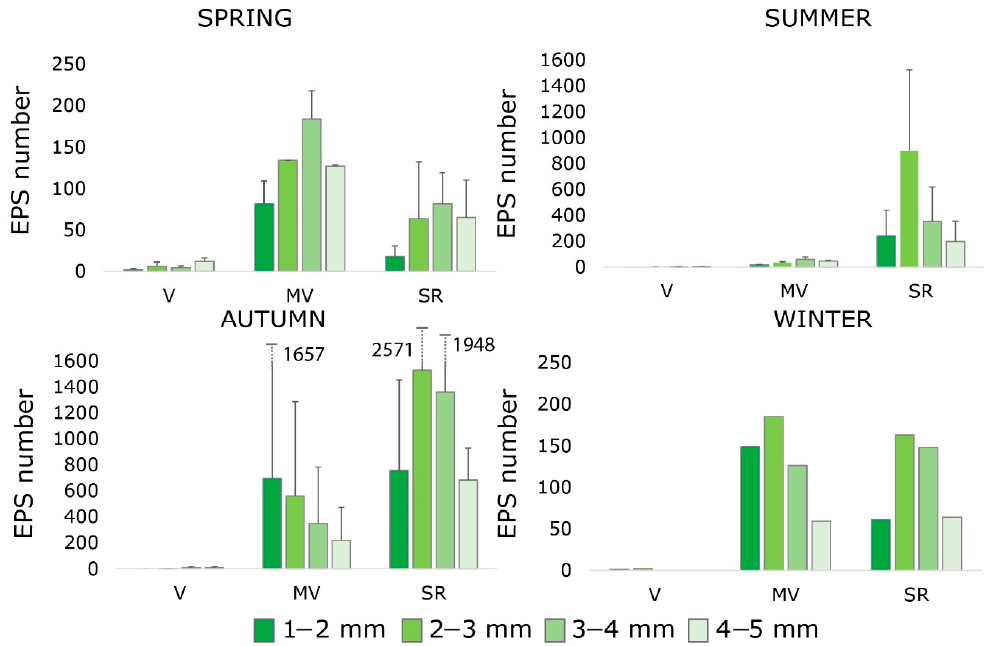
Figure 6. Seasonal analysis of the trend of the different size classes of EPS in the three sampled sites. In winter only one sampling was carried out, therefore there are no values for the standard deviation (data available in Table S4, Supplementary